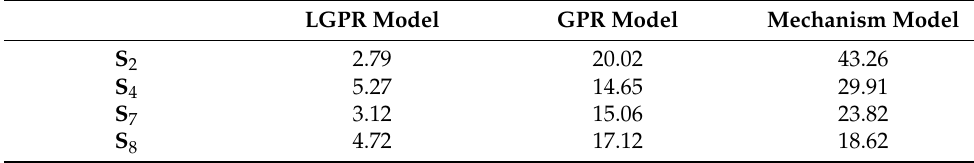
Table 2. The MARE (%) values of the LGPR, GPR, and mechanism models of test sets.